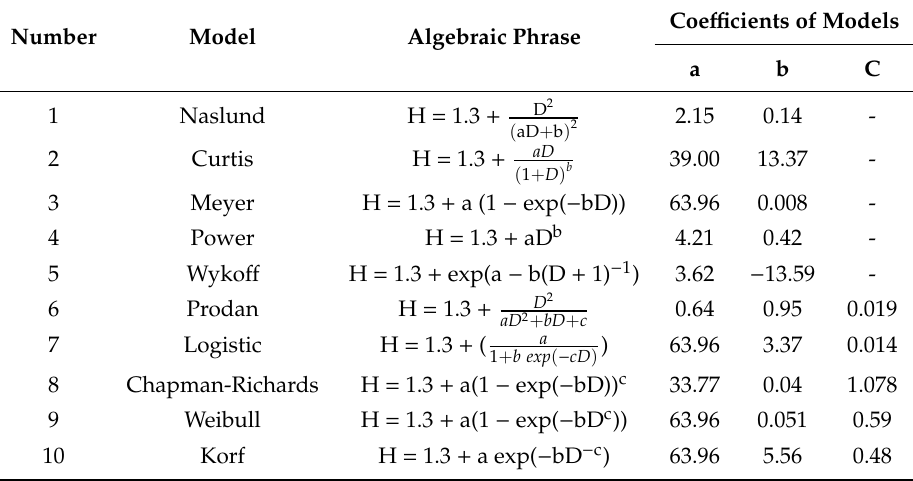
Table 5. Regression coe ffi cients of models developed in this